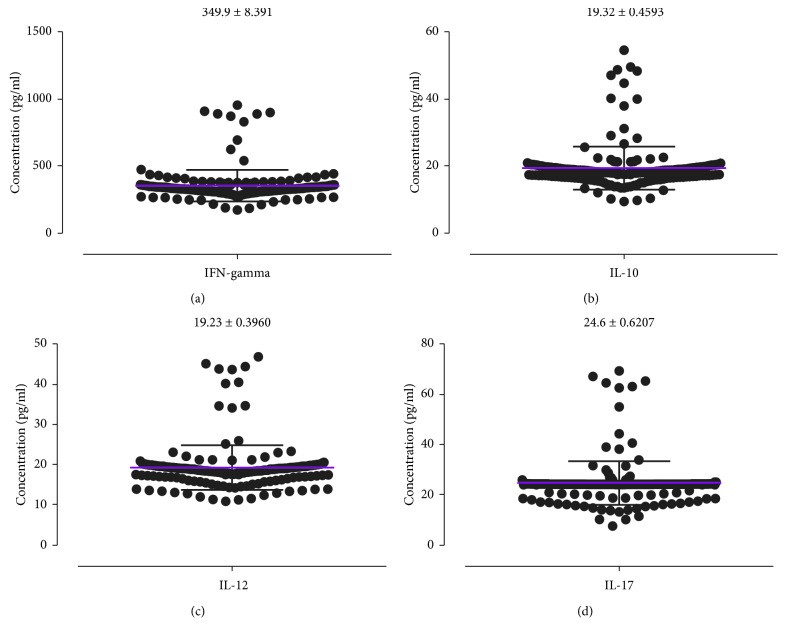
Distribution of cytokines among the study participants.